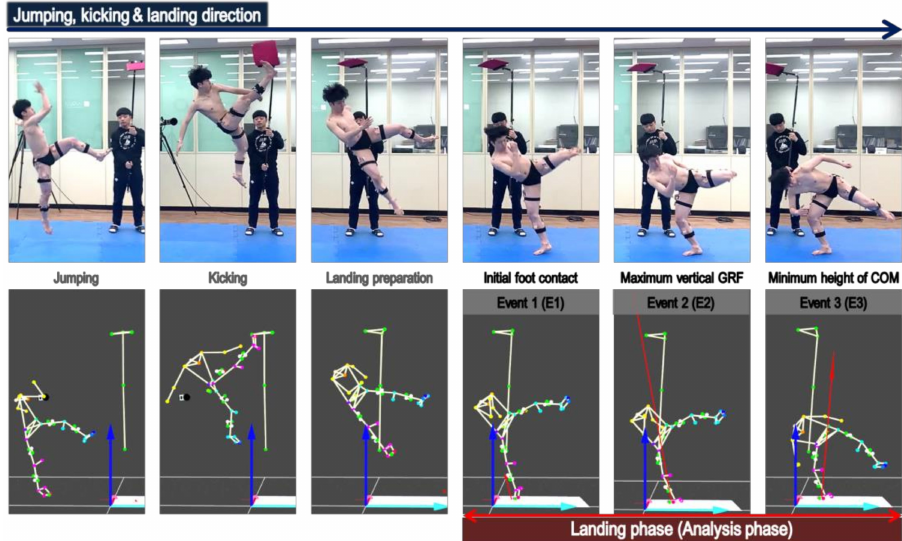
Figure 2. Experimental setup of jumping kick and analysis of the landing